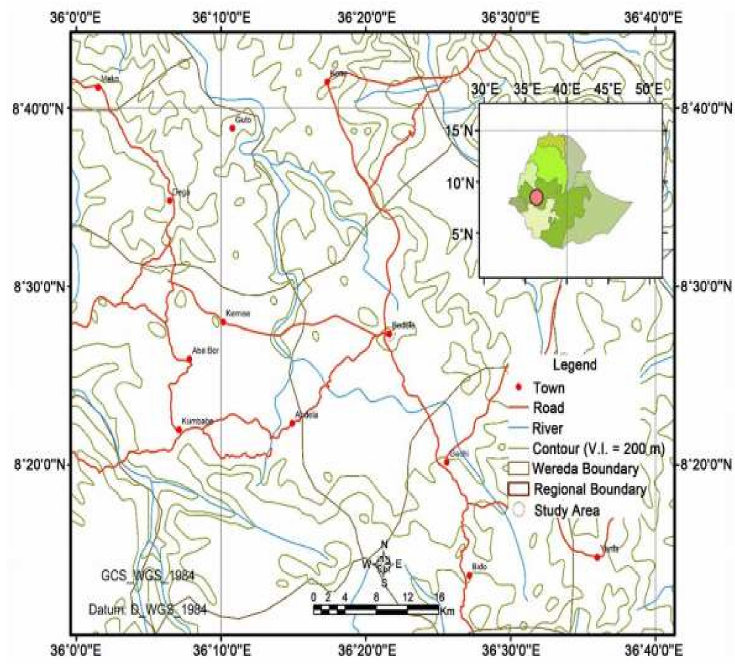
Figure 1. Location map of the seed collection area,